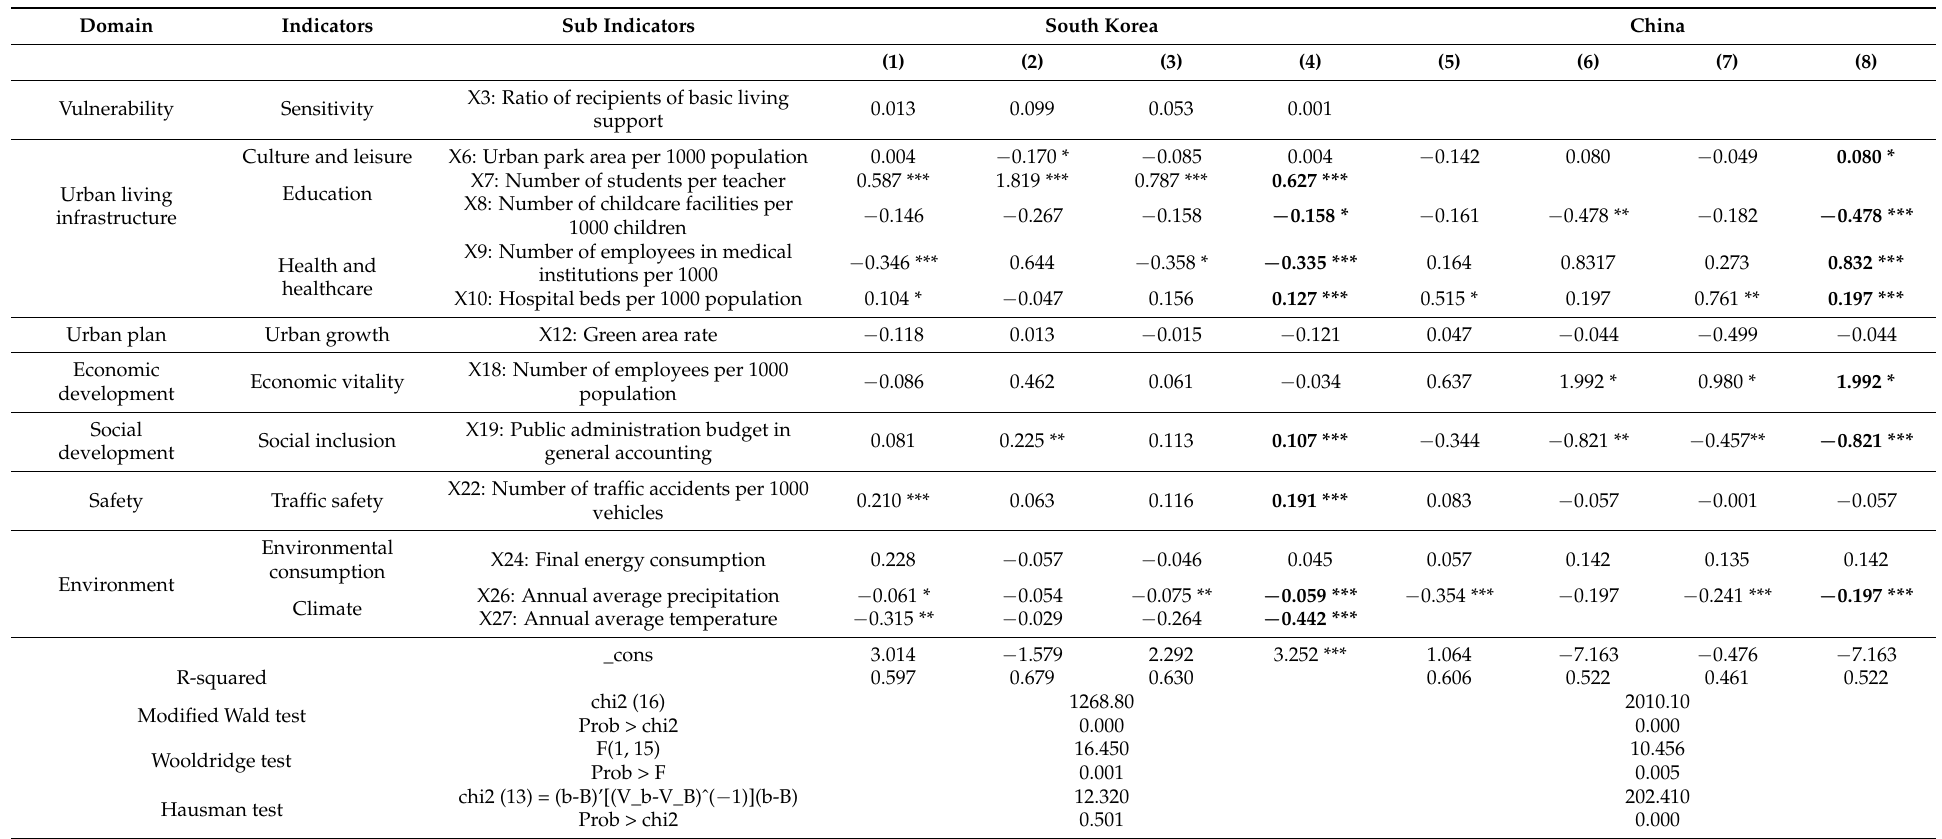
Table 3. Panel regression analysis